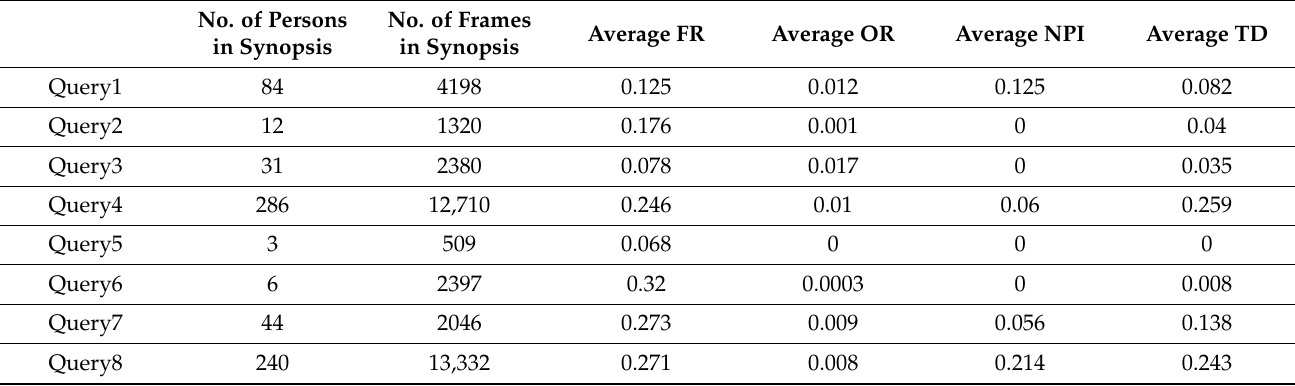
Table 3. Video synopsis performance